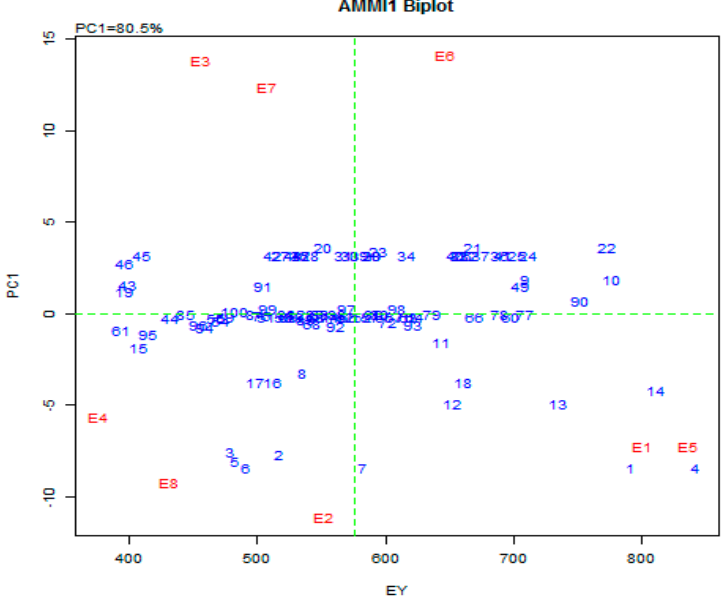
Figure 1. AMMI (Additive Main Effects and Multipicative Interaction) 1 biplot for grain yield per plot of 100 wheat genotypes and 8 environments using genotypic and Environmental scores.